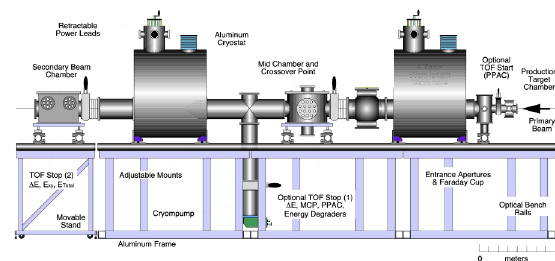
Figure 7. The original TwinSol .